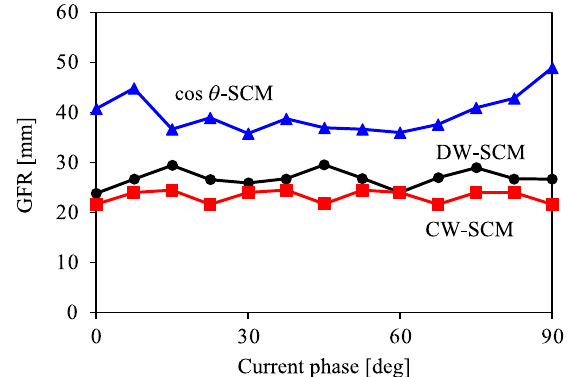
FIG. 7. Good field region (GFR) distributions of scanning magnets.